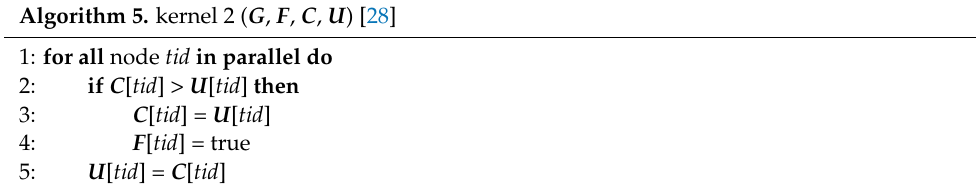
Algorithm 5. kernel 2 ( G , F , C , U )